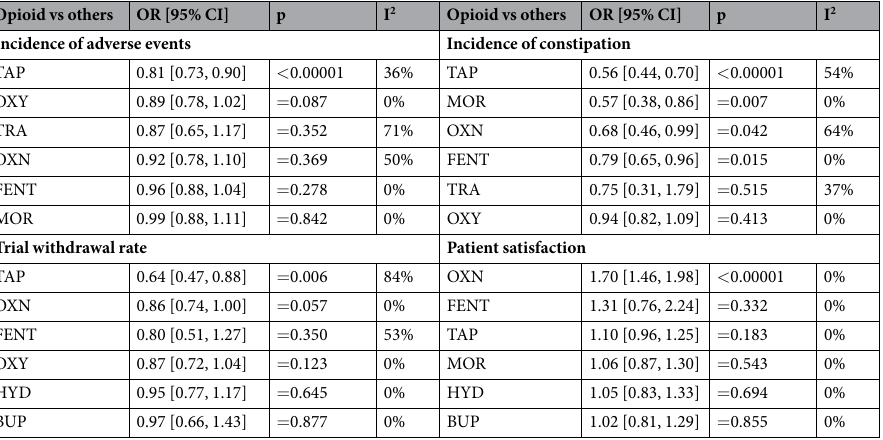
Table 1. Outcomes of the conventional meta-analyses showing the odds ratios between a selected opioids and other opioids in study endpoints. Abbreviations: BUP, buprenorphine; CI, confidence interval; FENT, fentanyl; HYD, hydromorphone; MOR, morphine; OR, odds ration; OXN, oxycodone-naloxone; OXY, oxycodone; TAP, tapentadol; TRA,